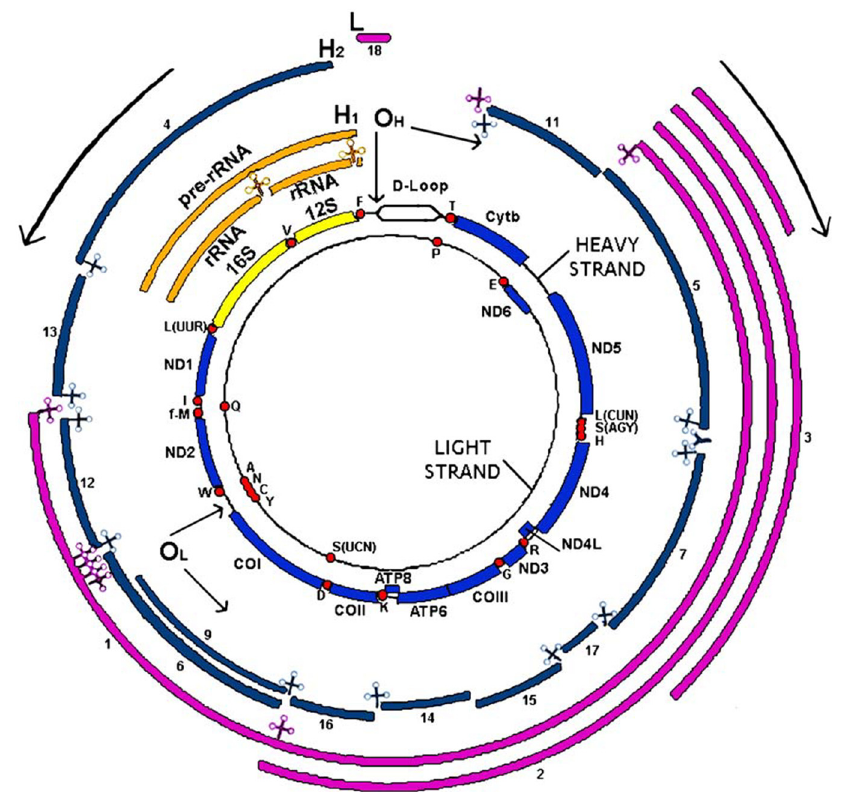
Figure 1. Human mitochondrial DNA: genetics and transcription. The two internal circles represent both mtDNA strands with the encoded genes in yellow ( rRNAs ), red dots ( tRNAs ) and blue (protein coding genes). External circles represent the RNAs transcribed from the heavy strand (in orange or in blue for the RNAs derived from the H1 or H2 transcription units) and light strand (in pink). ND1 to ND6 are subunits 1–6 of NADH dehydrogenase (complex I); cyt b , cytochrome b, is a subunit of complex III; CO I, CO II and CO III are subunits of cytochrome c oxidase (complex IV) and ATP6 and ATP8 , subunits of ATP synthase (complex V). tRNA genes are indicated by the one letter code of the corresponding amino acid. OH and OL represent replication origins for the H- and L-strand, respectively, according to the classical model of replication. H1, H2 and L indicate initiation points for the three transcription units of the H- and L-strand, respectively. Arrows at the OH and OL, and in the outside part of the figure, indicate the direction of replication and transcription of both strands